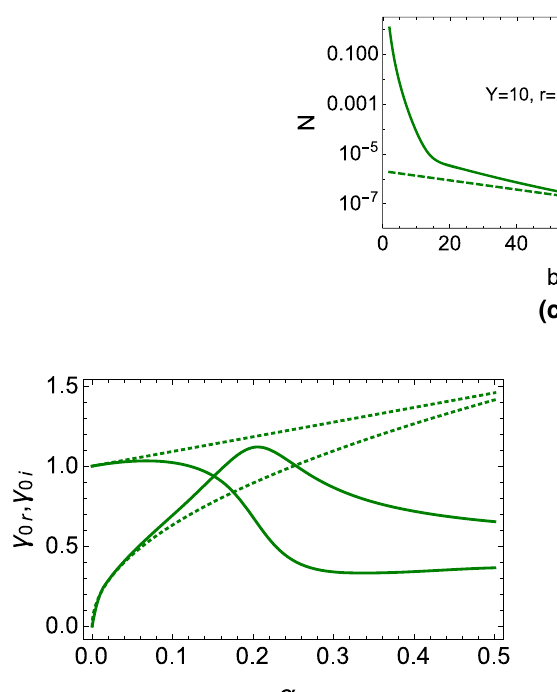
Fig. 4 Numerical estimates of Eq. (44) for different values of r = R at Y = ln ( 1 / x ) = 10 (solid lines). The dotted lines denote N ∝ exp ( − μ b ) . The slope μ is in GeV , while r and b are in GeV − 1 . For all estimates ¯ α S = 0 . 2